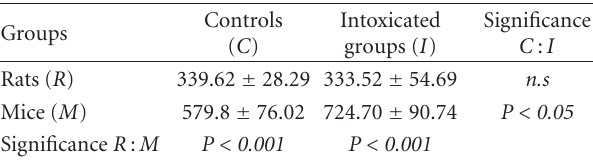
Table 1: MDA + 4HDA concentration ( µ mol/g of the tissue) in groups of intoxicated rats and mice and in control